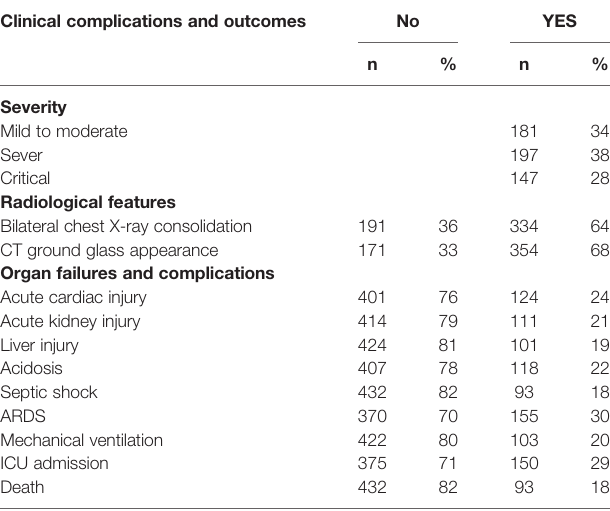
TABLE 5 | Clinical complications and clinical outcomes of 525 symptomatic COVID-19 patients. Clinical complications and outcomes